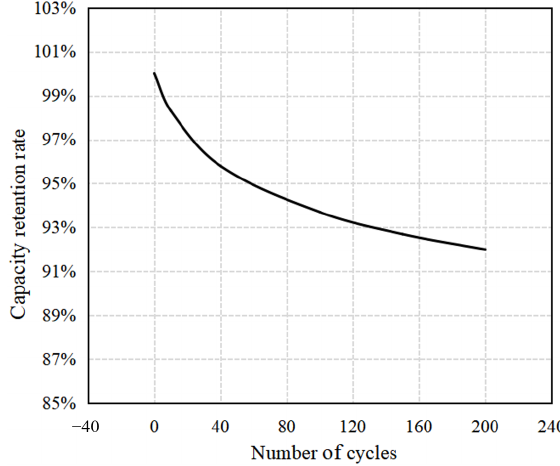
Figure 10. Capacity decay curve of lithium-ion battery.